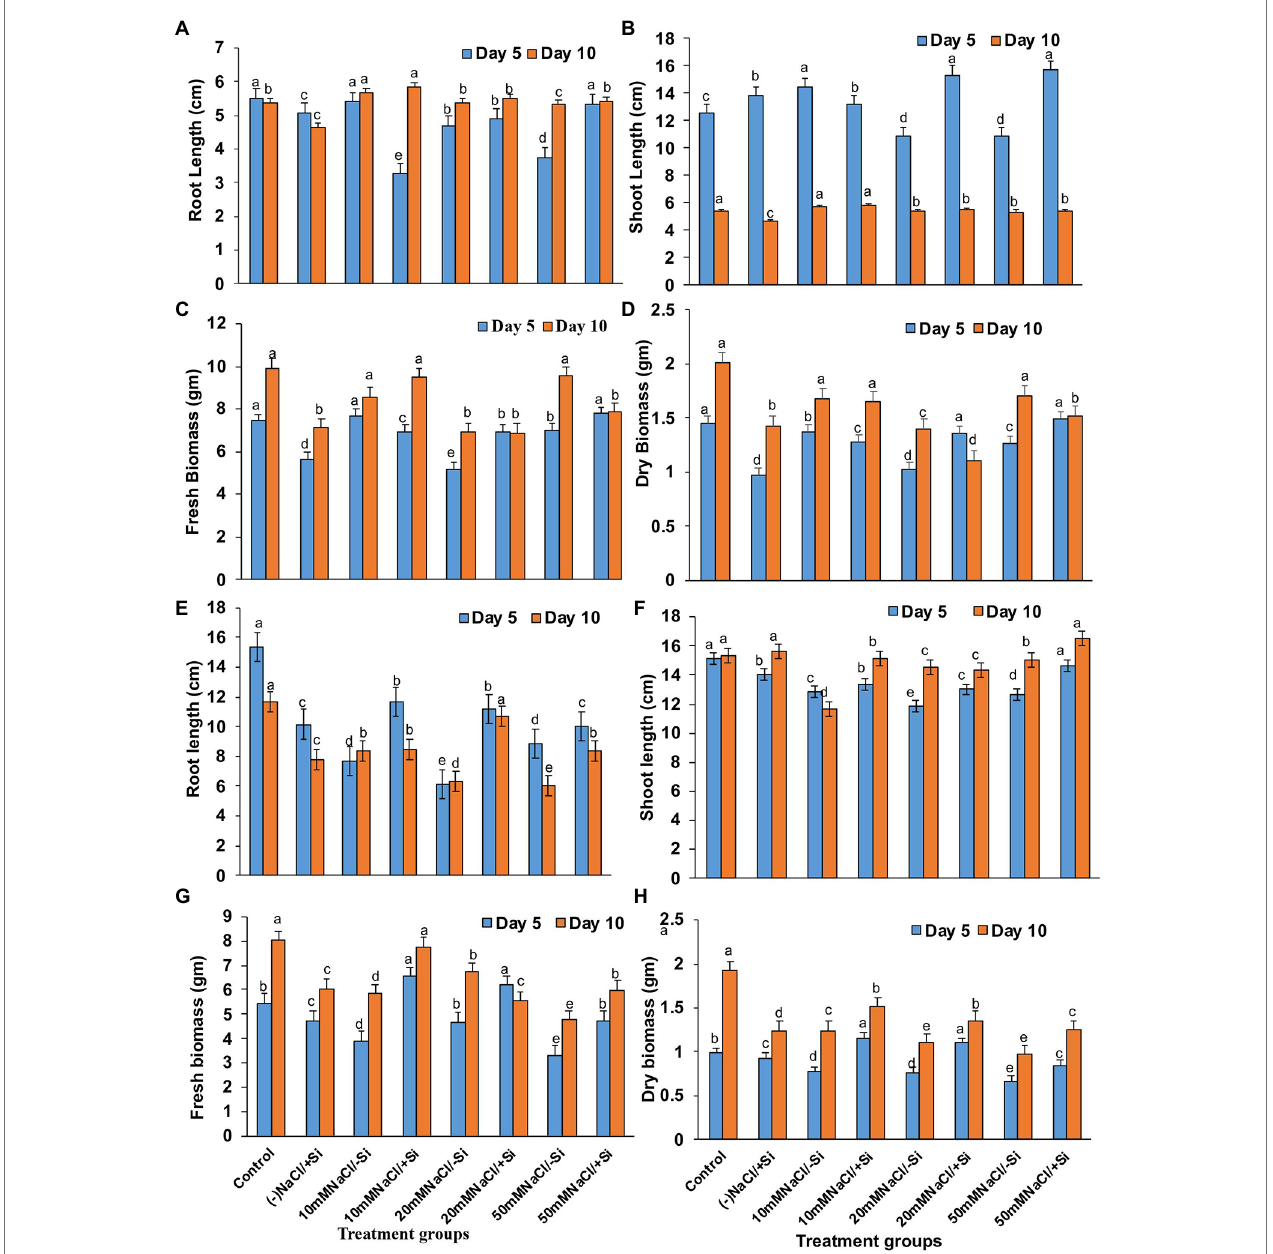
FIGURE 3 | Changes in (A,E) root length, (B,F) shoot length, (C,G) fresh biomass, and (D,H) dry biomass of mung bean ( Vigna radiata ) under 1 mM (Si 1 ) Si supply and salinity stress after eight treatments: (i) control (T1), (ii) − NaCl+Si (1 mM/5 mM) (T2), (iii) 10 mM NaCl/ − Si (T3), (iv) 10 mM NaCl/+Si (1 mM/5 mM) (T4), (v) 20 mM NaCl/ − Si (T5), (vi) 20 mM NaCl/+Si (1 mM/5 mM) (T6), (vii) 50 mM NaCl/ − Si (T7), and (viii) 50 mM NaCl/+Si (1 mM/5 mM) (T8) for a period of 5 and 10 days. Vertical bars indicate Mean ± SE of the means for n = 4. Means denoted by the different letters are significantly different at p ≤ 0.05 according to the Tukey’s studentized range